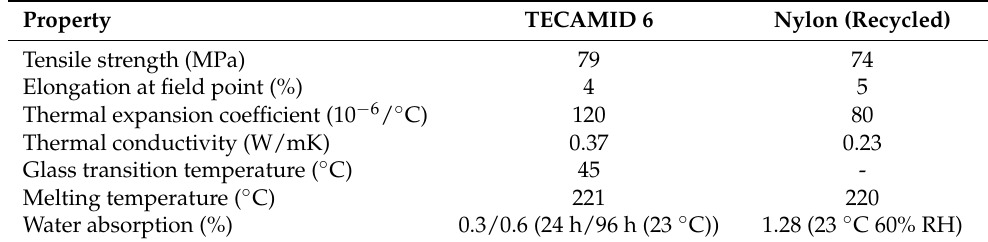
Table 1. Properties of the